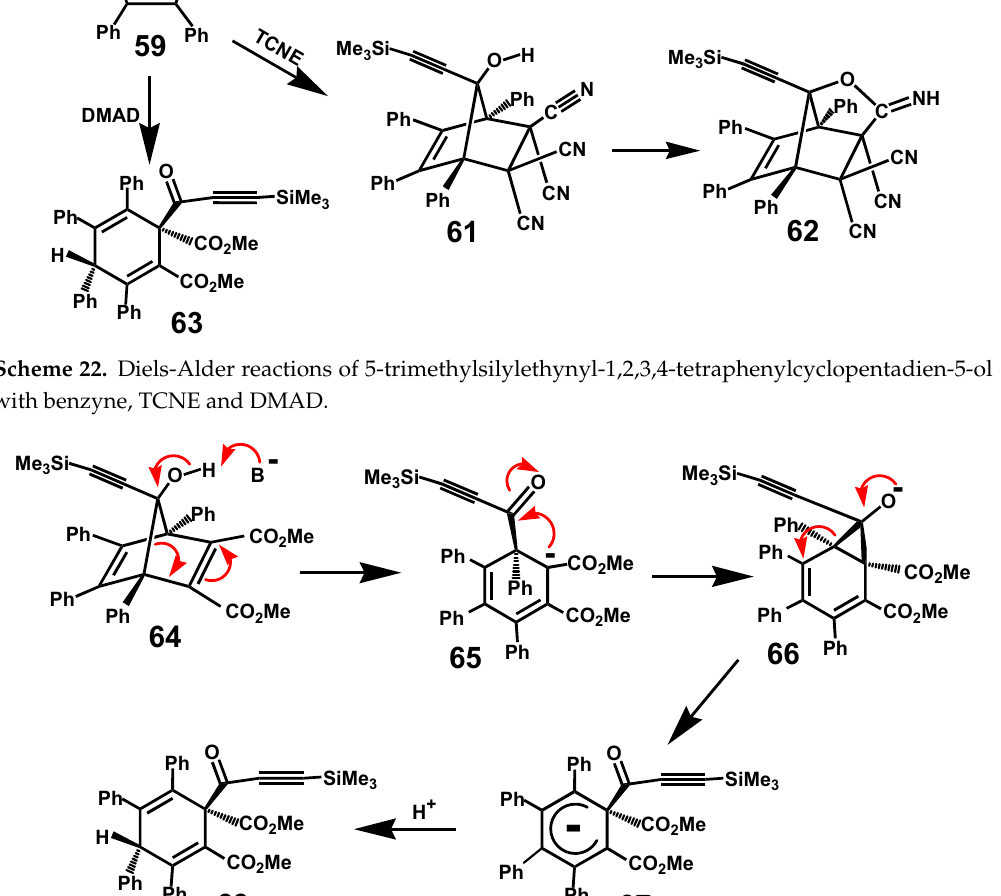
Scheme 22. Diels-Alder reactions of 5-trimethylsilylethynyl-1,2,3,4-tetraphenylcyclopentadien-5-ol with benzyne, TCNE and DMAD.